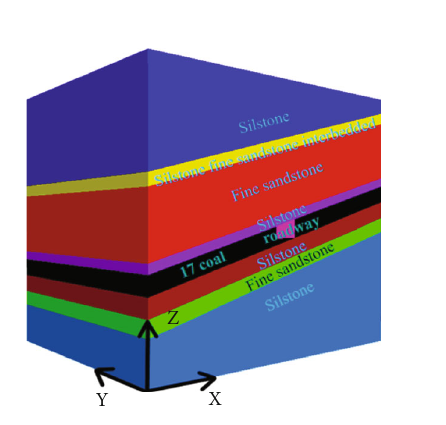
Figure 4: 3D mode diagram.